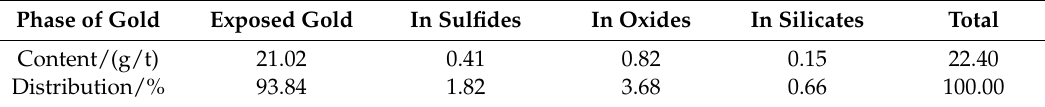
Table 7. The result of chemical phase analysis of Au in the mixed pretreated